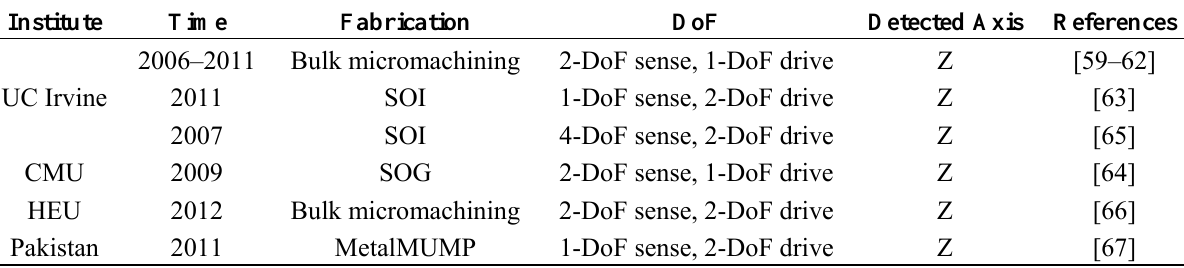
Table 6. The summary of multi-DoF